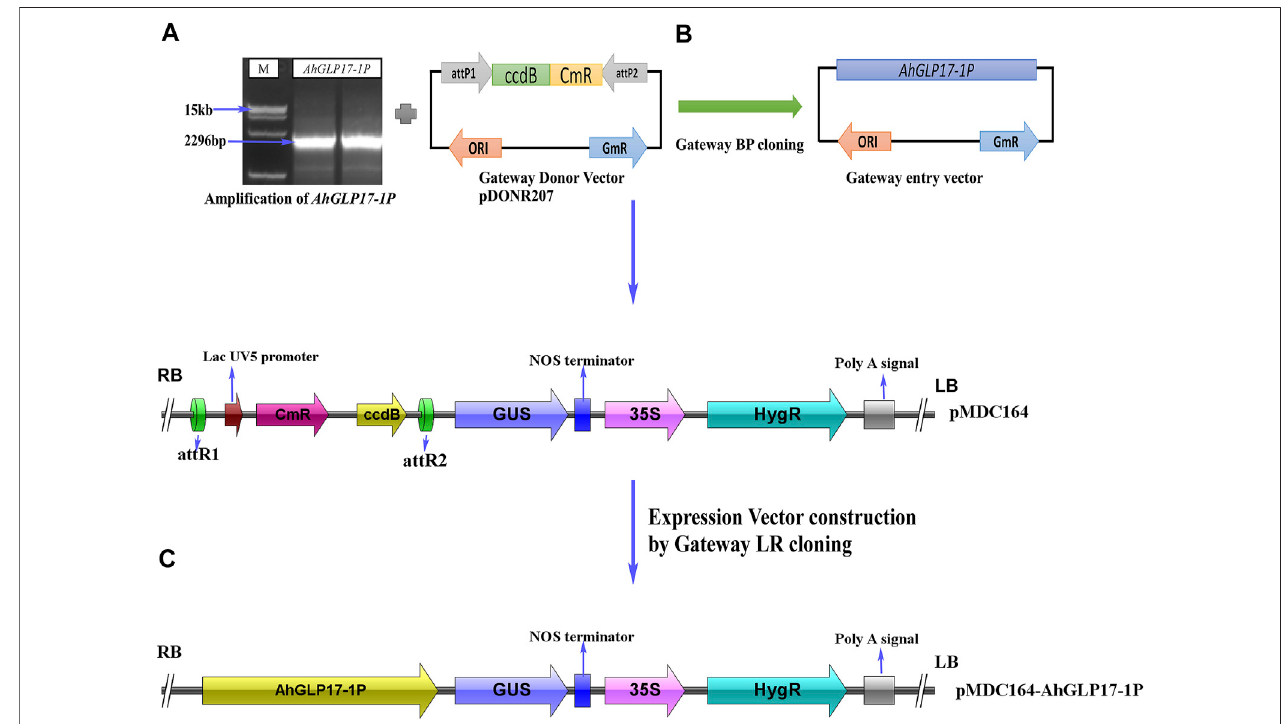
FIGURE 4 | Construction of vectors using the backbone of pMDC164 vector by Gateway cloning. (A) Ampli fi cation of AhGLP17-1P promoter, (B) construction of Gateway entry vector by Gateway BP-cloning, (C) construction of Gateway expression vector using the backbone of binary vector